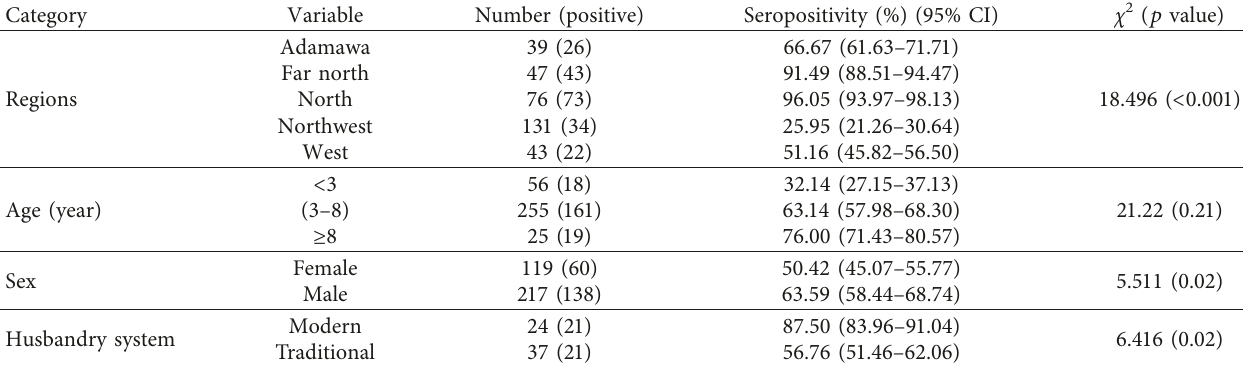
Table 2: Seropositivity of African horse sickness among the horses in the study area.